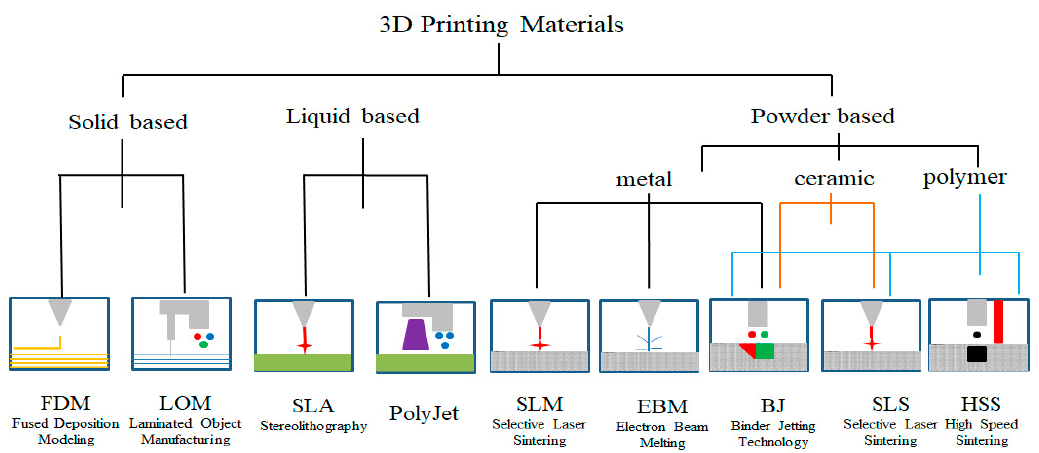
Figure 1. 3D printing technical classification according to printing materials.